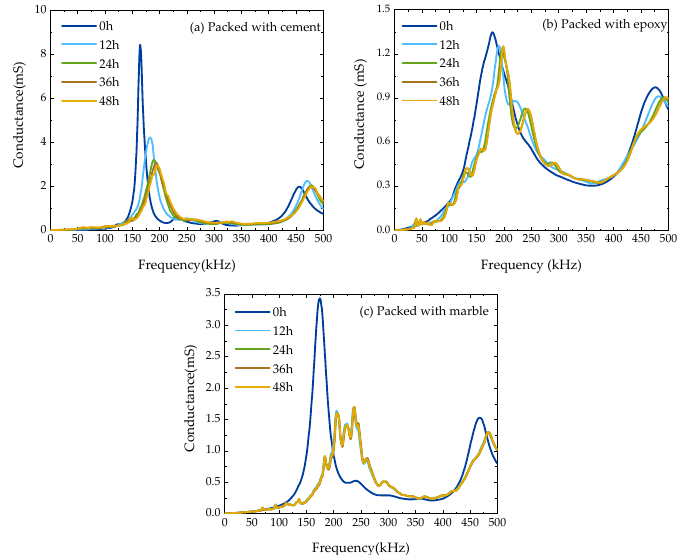
Figure 4. Conductance spectra measured from the PZT sensors with cement packing ( a ), epoxy packing ( b ), and marble packing ( c ) during fabrication.